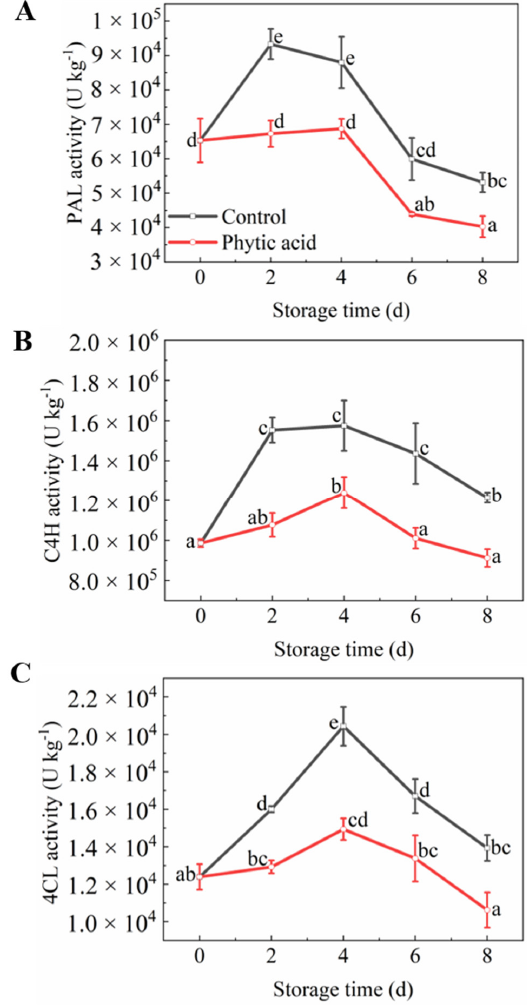
Figure 6. Phenylpropane metabolism-related enzyme activities of fresh-cut apples during storage after treatment with phytic acid or the control. ( A ) PAL activity; ( B ) C4H activity; ( C ) 4CL activity. Vertical bars represent standard errors of the means of three replicates. The different letters indicate significant differences at p < 0.05.